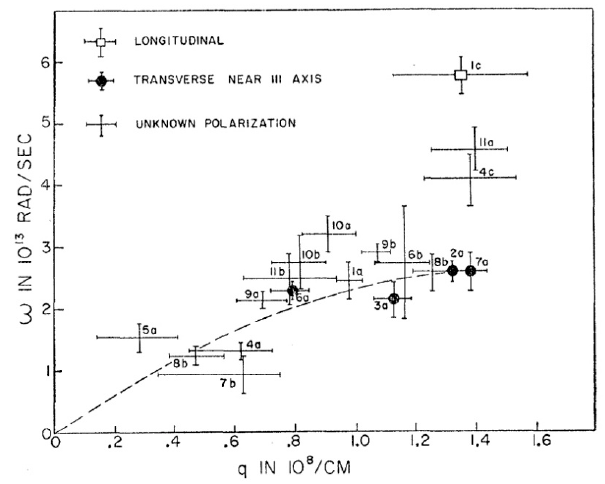
Figure 5. The relation between the phonon frequency, ω (10 13 radians/sec), and the phonon wavevector, q , (10 8 cm − 1 ), near the [111] direction in aluminum. Modes that have been positively identified as transverse or longitudinal are indicated by solid and open circles. Phonons of unknown polarization are indicated by dots. The dashed curve is a sine curve whose initial slope corresponds to a velocity of sound of 3080 ms − 1 for Al. This figure is taken from Figure 3 of ref. [20]. Copyright by the American Physical